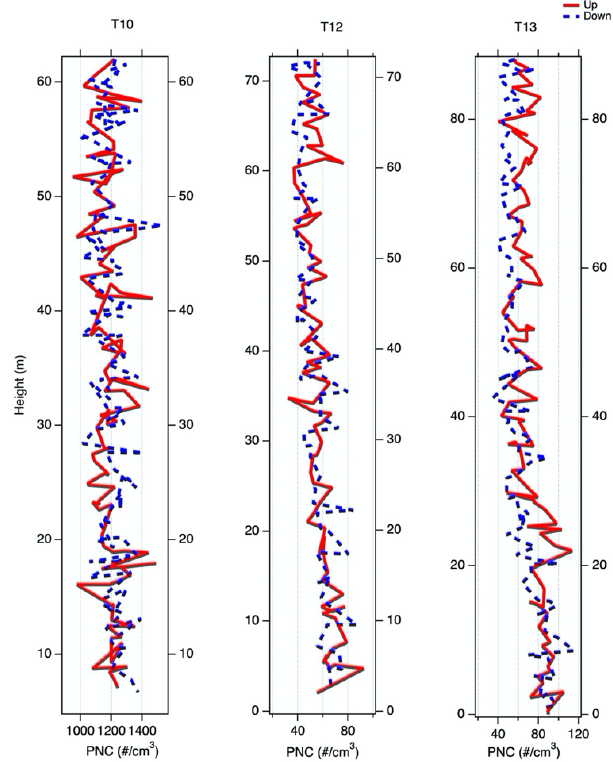
Figure 6. Vertical profiles of the particle number concentration in the profile runs of T10, T12, and T13. The red line shows the ob- served concentration on the way up and the blue dash line shows that on the way down, respectively.